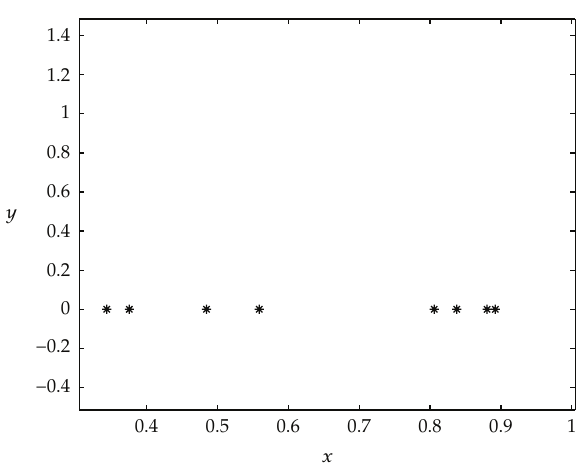
Figure 2: A stable 8-cycle of (cid:3) 2.2 (cid:4) for a (cid:8) 3 . 571920967580968, b (cid:8) 0 . 2, d (cid:8) 1 . 4.